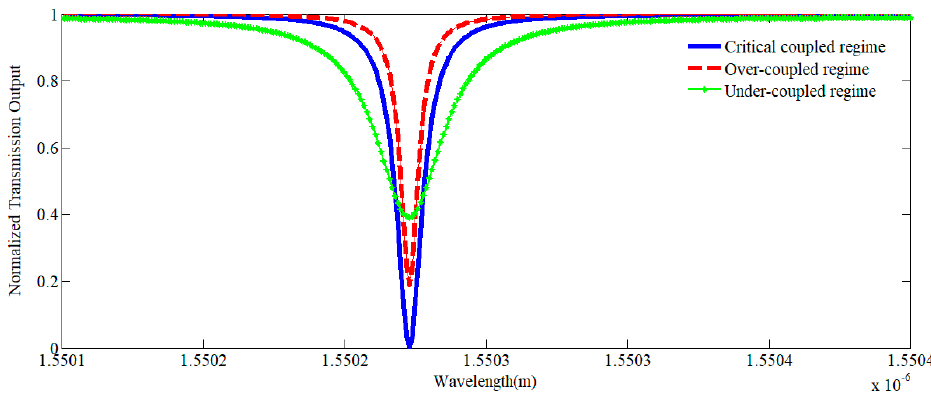
ff erent coupling regimes.